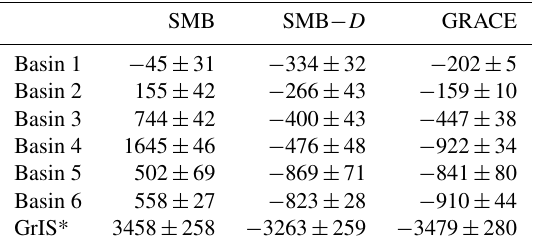
Table 1. GrIS-wide and basin-scale (delineated in Fig. S6) cumula- tive mass changes in gigatonnes over the 2003–2016 period, listed as the RACMO2.3p2 SMB component, SMB − D mass balance, and GRACE mass balance estimates. Cumulative mass changes here represent the difference between mean annual 2016 and mean an- nual 2003 estimates, with a negative value indicating net mass loss. The GrIS* domain includes SMB fields from tundra and detached ice caps. SMB SMB − D GRACE Basin 1